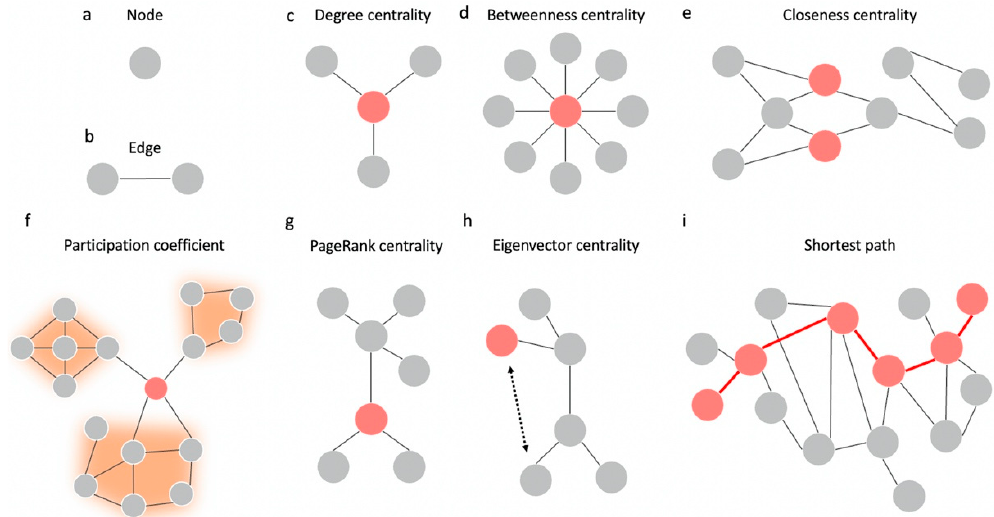
Figure 3. Visual representation of network centrality. In graphs of the brain, nodes ( a ) correspond to parts of the brain, while edges ( b ) signify either structural or functional connections. The nodes in red display the highest corresponding centrality. ( c ) The degree centrality is the number of direct neighbors a node has, such that the degree of the red node is 3. ( d ) The betweenness centrality measures the extent to which a node acts as a bridge between two other nodes. ( e ) Closeness centrality measures how fast a given node can access every other node in the graph. ( f ) Participation coefficient is a measure of the distribution of a node’s connections among the modules in a network, with each module represented in orange. ( g ) PageRank centrality scales the influence of a node’s neighbors by its degree. ( h ) Eigenvector centrality considers the quality of a node’s neighbors when quantifying its centrality. The red node has a higher eigenvector centrality than the grey node (pointed to by the dashed arrow), despite their degrees being the same. ( i ) Path length is a measure used to calculate the efficiency of information flow in a given network. Figure adapted from Farahani et al. (2019) [7] .